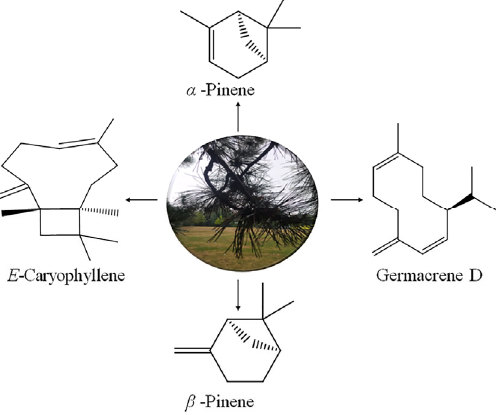
Figure 1. Molecular structures of the identified dominant components of the essential oil of Pinus nigra needles.